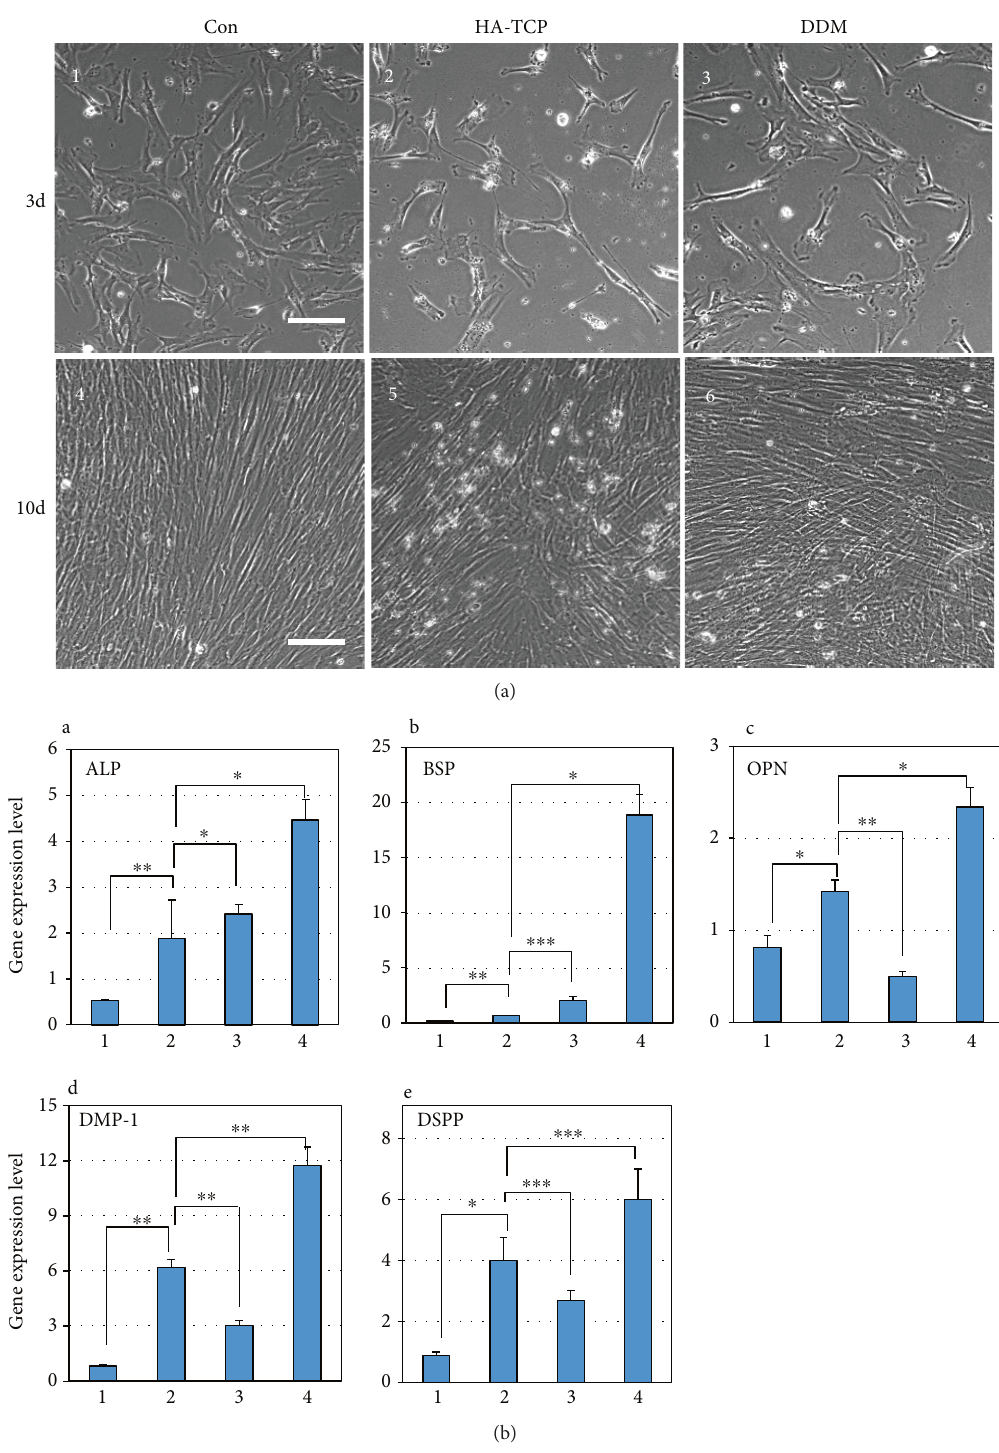
Figure 2: Osteoinduction potentials of HA-TCP and DDM on hDPSCs in vitro. (a) Morphology of hDPSCs cultured in the extracts of HA- TCP and DDM for 3 and 10 days. 1 and 4, hDPSCs cultured in α -MEM with 10% FBS, indicated as Con ; 2 and 5, hPDSCs cultured in HA-TCP extract; 3 and 6, hDPSCs cultured in DDM extract. Scale bars: 100 μ m. (b) Gene expression of osteogenic and dentinogenic markers in hDPSCs cultured in the extracts of HA-TCP and DDM. Gene expressions of ALP (A), BSP (B), OPN (C), DMP-1 (D), and DSPP (E) were analyzed by the qRT-PCR. 1, actively growing hDPSCs; 2, hDPSCs in the prolonged culture for 10 days; 3, hPDSCs cultured in HA-TCP extract for 10 days; 4, hDPSCs cultured in DDM extract for 10 days. Statistical analyses were carried out using Student ’ s t -test. ∗ p < 0 05 ; ∗∗ p < 0 01 ; ∗∗∗ p < 0 001